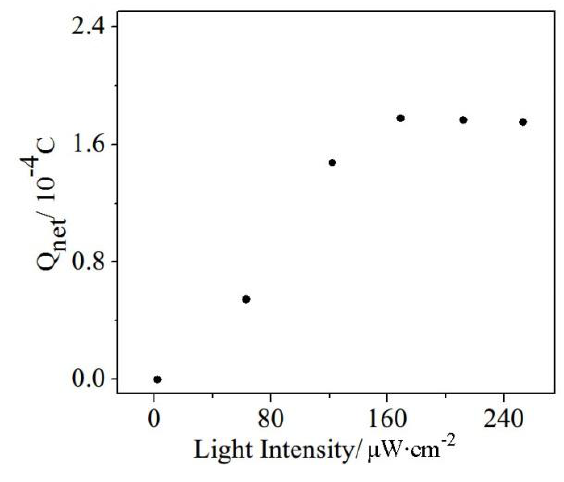
Figure 5. Effect of the light intensity on Q